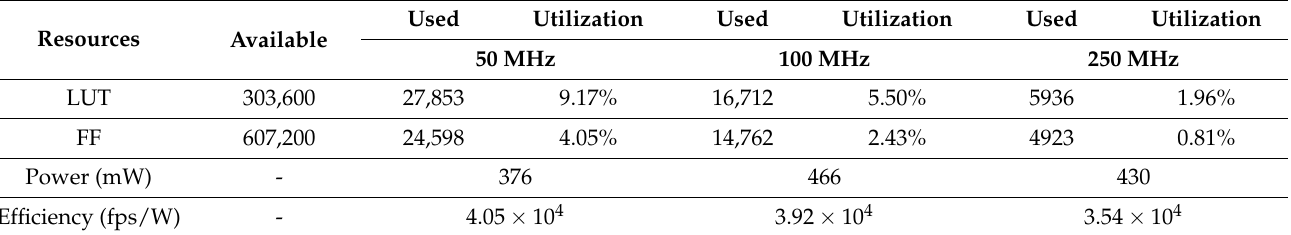
Table 5. FPGA implementation